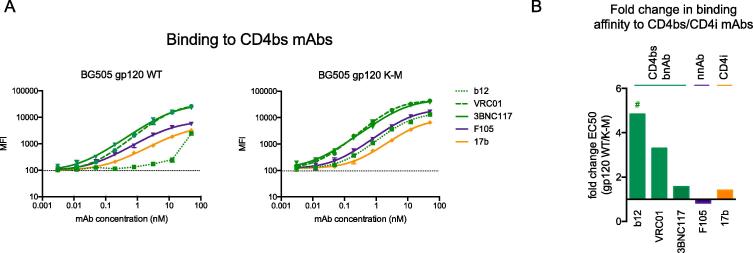
V1V2 K-M may alter binding of CD4bs mAbs in the context of gp120. A. Binding of gp120 WT and K-M to a panel of CD4bs and CD4i mAbs [CD4bs bnAbs in dark green: b12 (dotted), VRC01 (dashed), 3BNC117 (solid); CD4bs non-neutralizing F105 (purple); CD4i mAb 17b (orange)]. B. Fold change in binding affinity of gp120 K-M to CD4bs/CD4i mAbs relative to WT. Fold change was calculated as ratio of WT/K-M EC50 values as calculated by non-linear sigmoidal curve fits in GraphPad Prism. Values > 1 indicate enhanced K-M binding, while values < 1 indicate decreased K-M binding. The EC50 value for gp120 WT to mAb b12 was ambiguous and was bounded by the highest concentration tested (50 nM) to determine the WT/K-M ratio (denoted by “#”). Dotted lines on y-axes represent background signal from no antibody controls, and error bars represent standard deviation of triplicate measurements. Nonlinear fit lines calculated in GraphPad Prism are shown for data where calculated EC50 values are non-ambiguous. (For interpretation of the references to colour in this figure legend, the reader is referred to the web version of this article.)